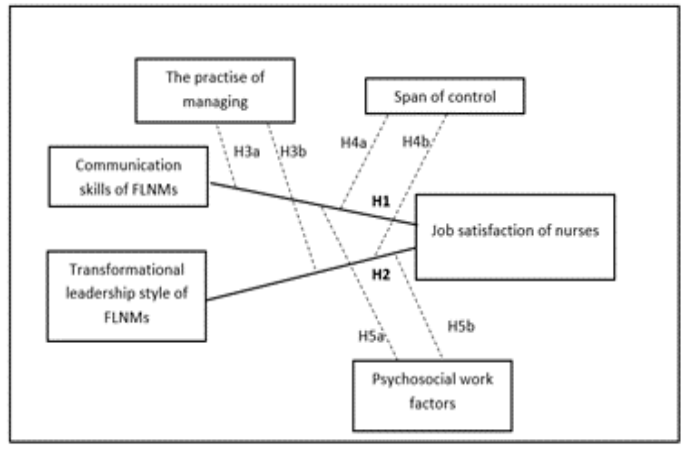
Figure 1. Model of the